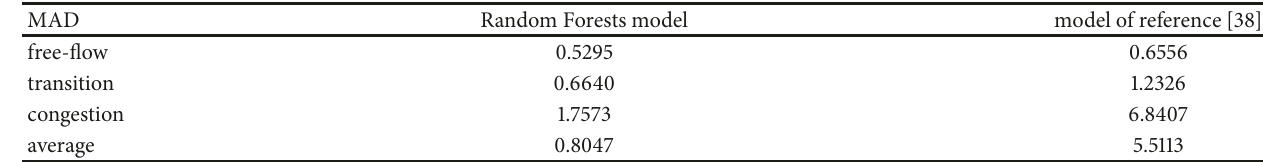
Table 8: The MAD of Random Forests model and reference [38] model.